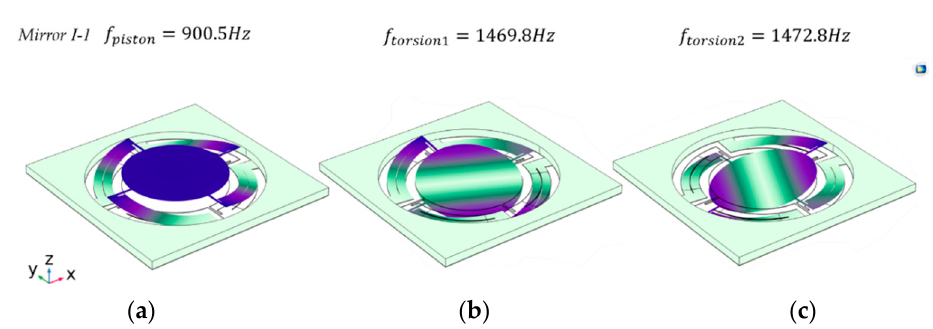
Figure 2. The mode shape results of Design I : ( a ) the first mode of the mirror is piston mode; in this mode, the mirror resonates along the z-axis; ( b ) the second mode is the tip mode and resonates at 1469.8 Hz; ( c ) the tilt mode resonates at 1472.8 Hz. Table 1. The main parameters of Mirror I - 1.